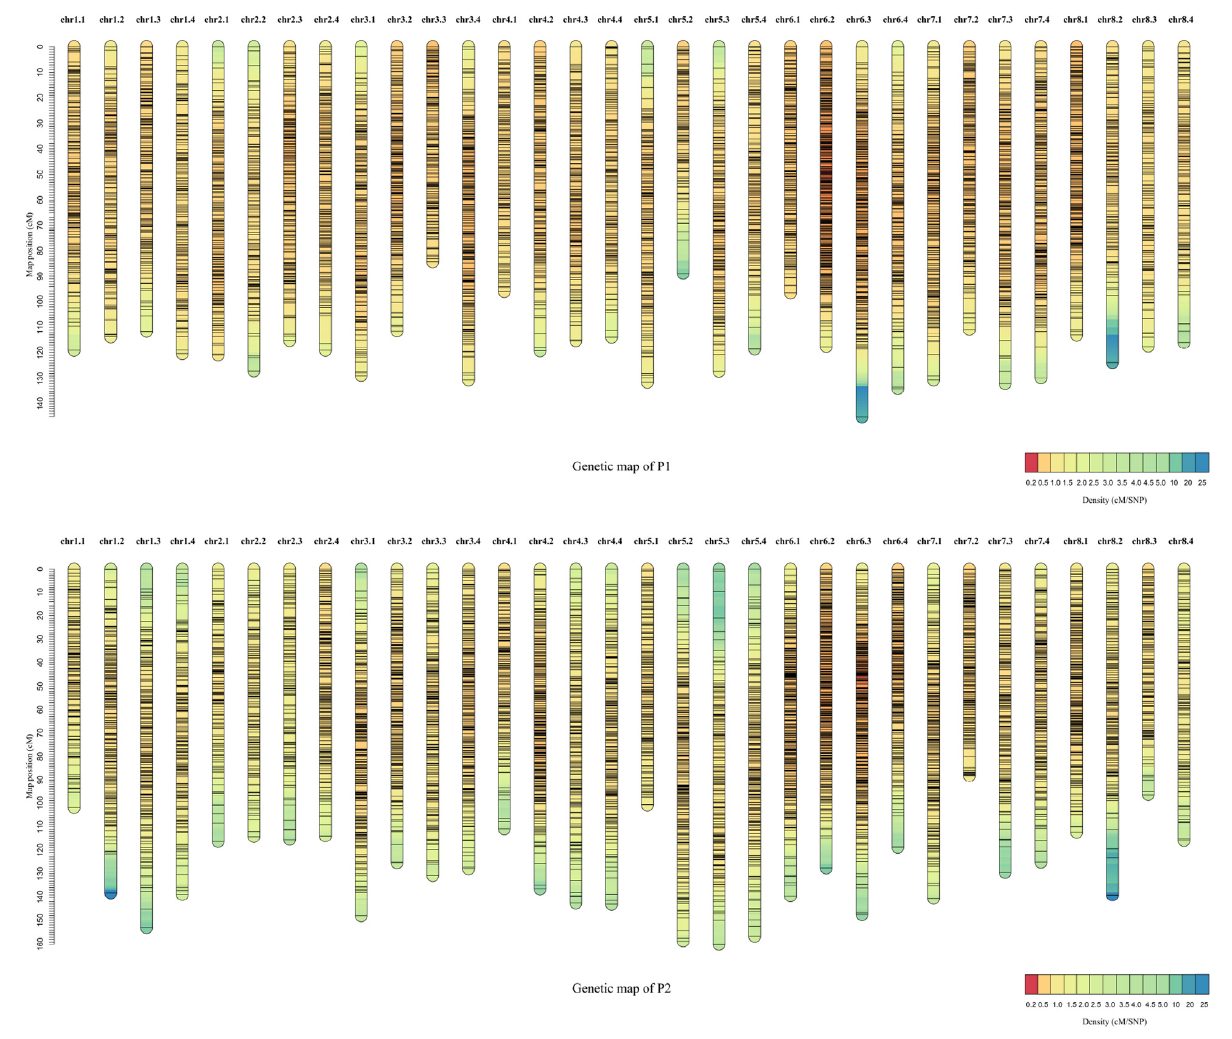
FIGURE 3 | Genetic linkage maps for the F 1 population. Distribution of 6,844 and 6,929 single-dose allele (SDA) markers in the parent (P1) and parent (P2) genetic maps, respectively. X -axis is the chromosome number and Y -axis describes the CentiMorgan distance. Detailed information on the maps is listed in Supplementary Table 1